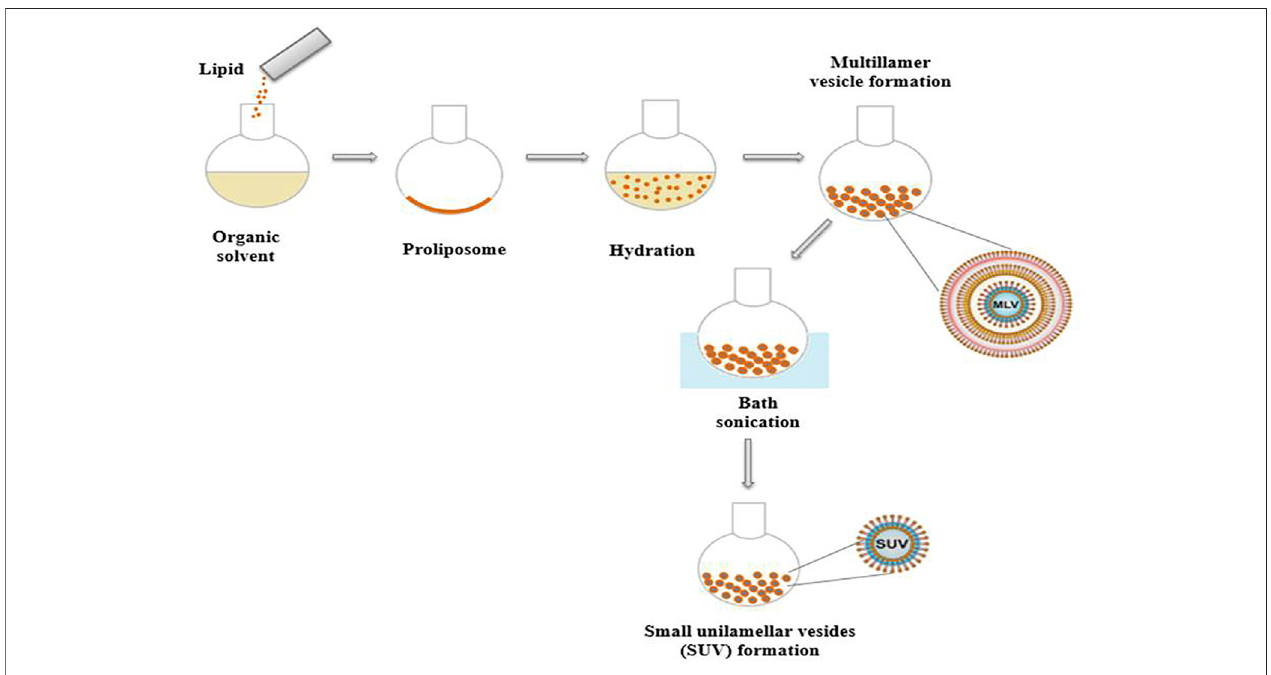
FIGURE 3 | Schematic representation of liposome